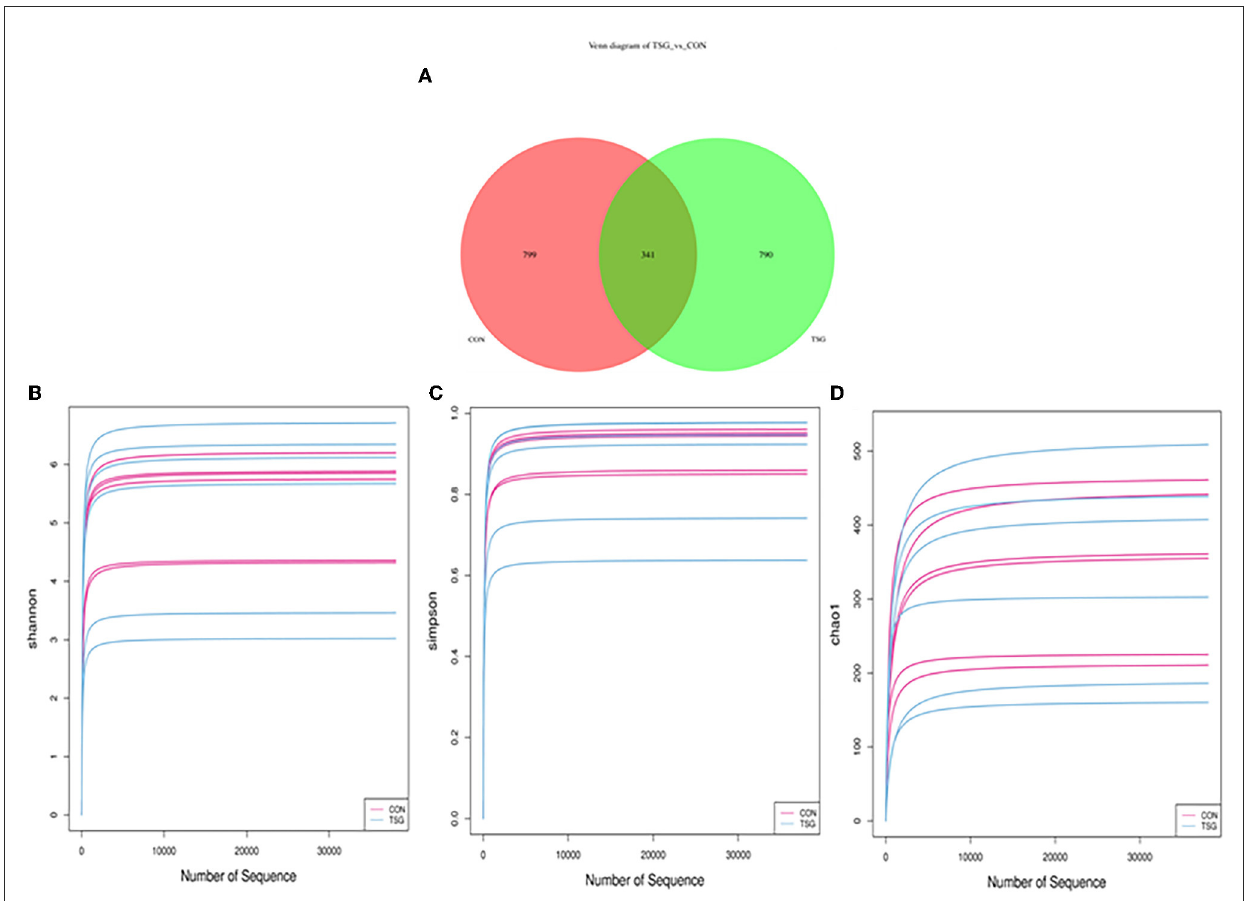
FIGURE3 16S rRNA: Venn diagram and alpha diversity analysis. (A) Showed that the pink area was the unique OTUs of the control group. The green area was the unique OTUs of the TSG group. The overlapping area in the middle is common to the TSG group of con combination. In addition, (B–D) separately showed the dilution curve corresponding to Shannon (B) , Simpson (C) , and Chao1 index (D) .